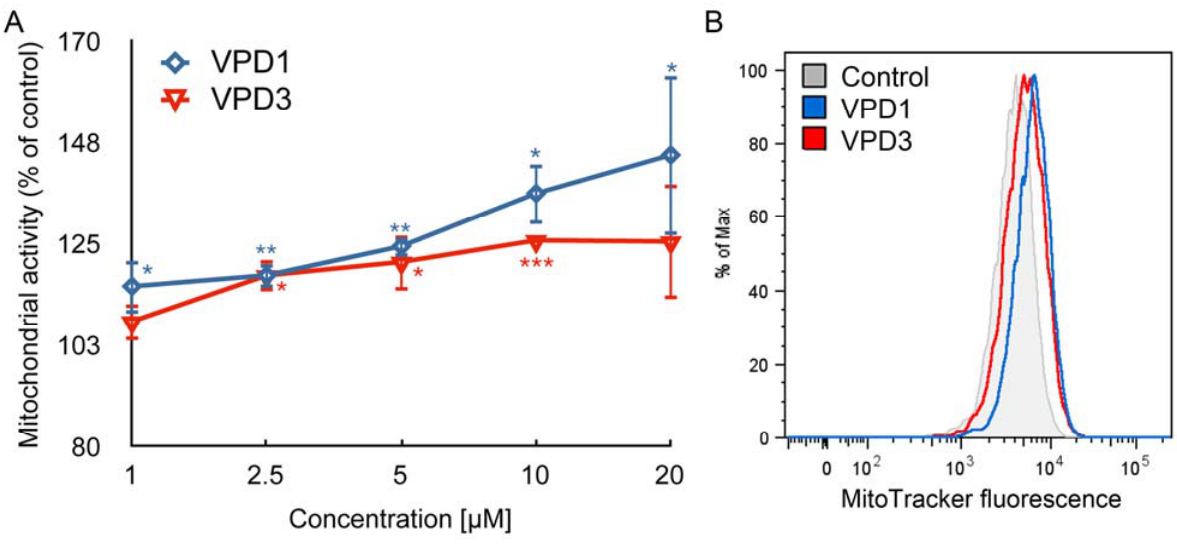
Figure 4. Alterations in oxidative activity of mitochondria in mHippoE-18 cells after 24 h treatment with VPDs ( A ) (n = 3, * p < 0.05, ** p < 0.01, *** p < 0.001). PPI was used as a positive control (231.59 ± 9.11 **). ( B ) is a representative histogram showing MitoTracker Orange fluorescence intensity in the control and samples treated with 20 μ M of VPDs. Statistical differences occur for VPD1 between concentrations 1 and 20 μ M, as well as 2.5 and 20 μ M.